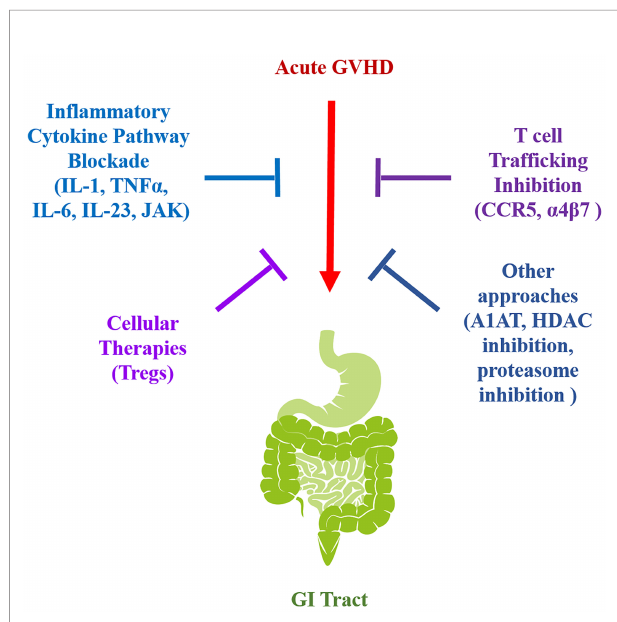
FIGURE 1 | Graphical schematic summarizing the translational strategies for GI GVHD